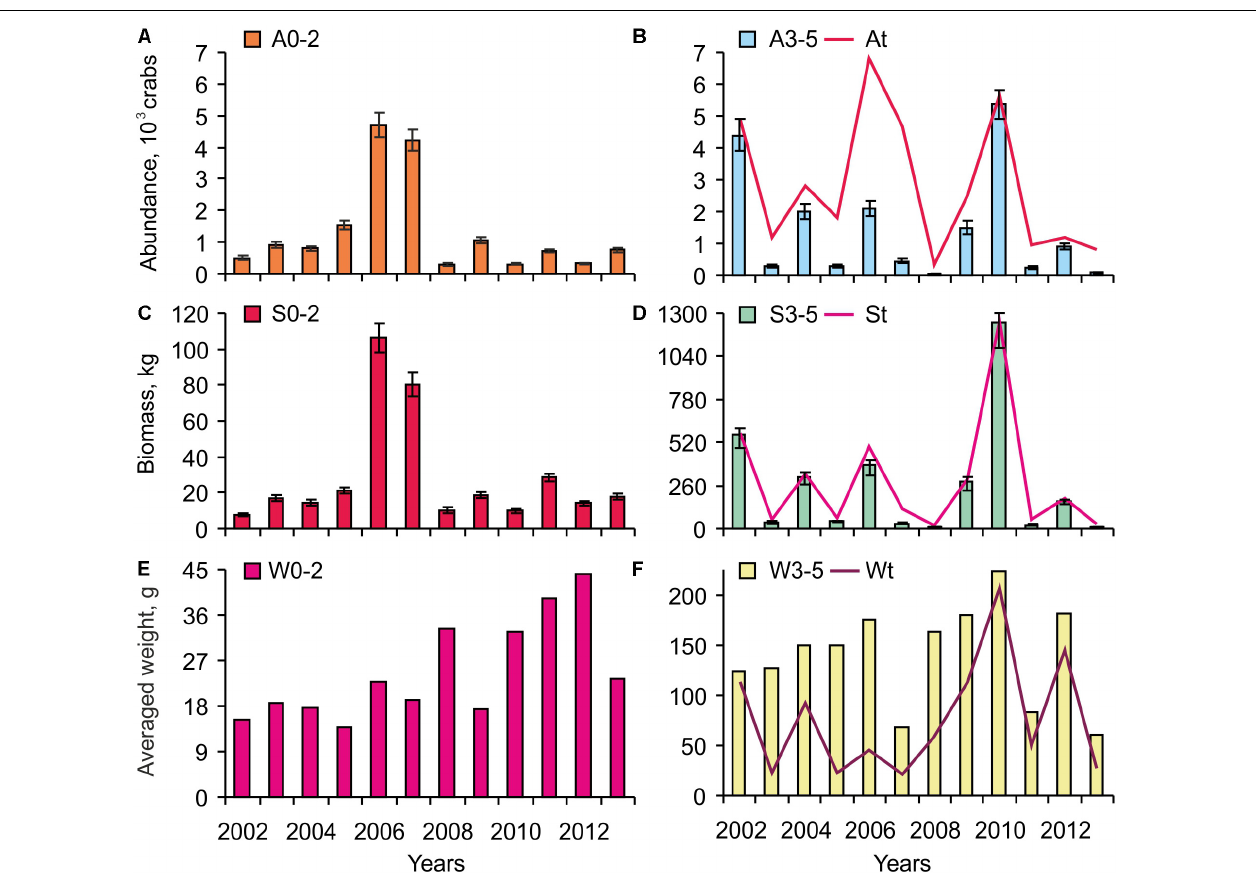
FIGURE 3 | Variations in red king crab indices over 2002–2013. A – abundance (A,B) , S – stock (C,D) , W – weight (E,F) . 0–2 – Age 0–2 year, 3–5 – Age 3–5 year, t – Age 0–5 year. Vertical bars show standard errors.